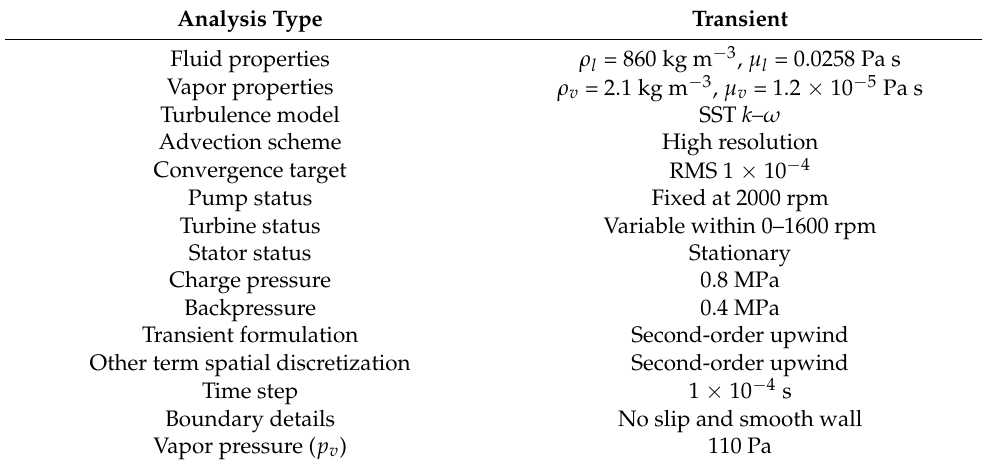
Table 2. Detailed computational fluid dynamics (CFD) model